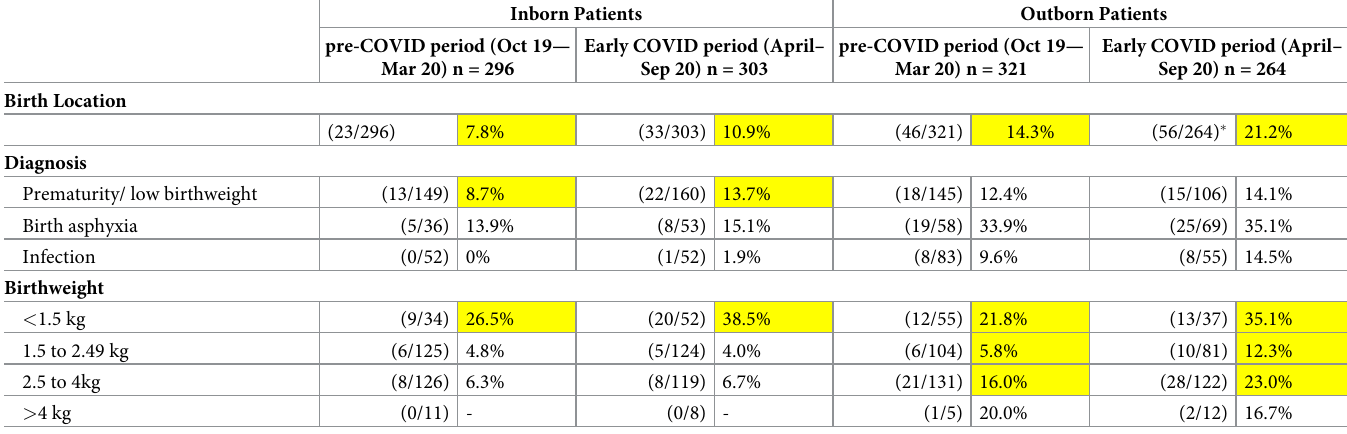
Mortality and admissions with birth asphyxia increased while outborn admissions decreased in this rural Ugandan neonatal unit during the first six months of the COVID-19 pandemic. The pandemic was associated with a relative increase in mortality by 36% and 55% excess mor- tality above seasonal trends among outborn patients. This increased mortality is likely attrib- uted to disruptions due to the pandemic affecting maternal and newborn demand for, access to and quality of peripartum healthcare [45]. Table 3. Mortality by birth location, birthweight and diagnosis during early COVID and pre-COVID